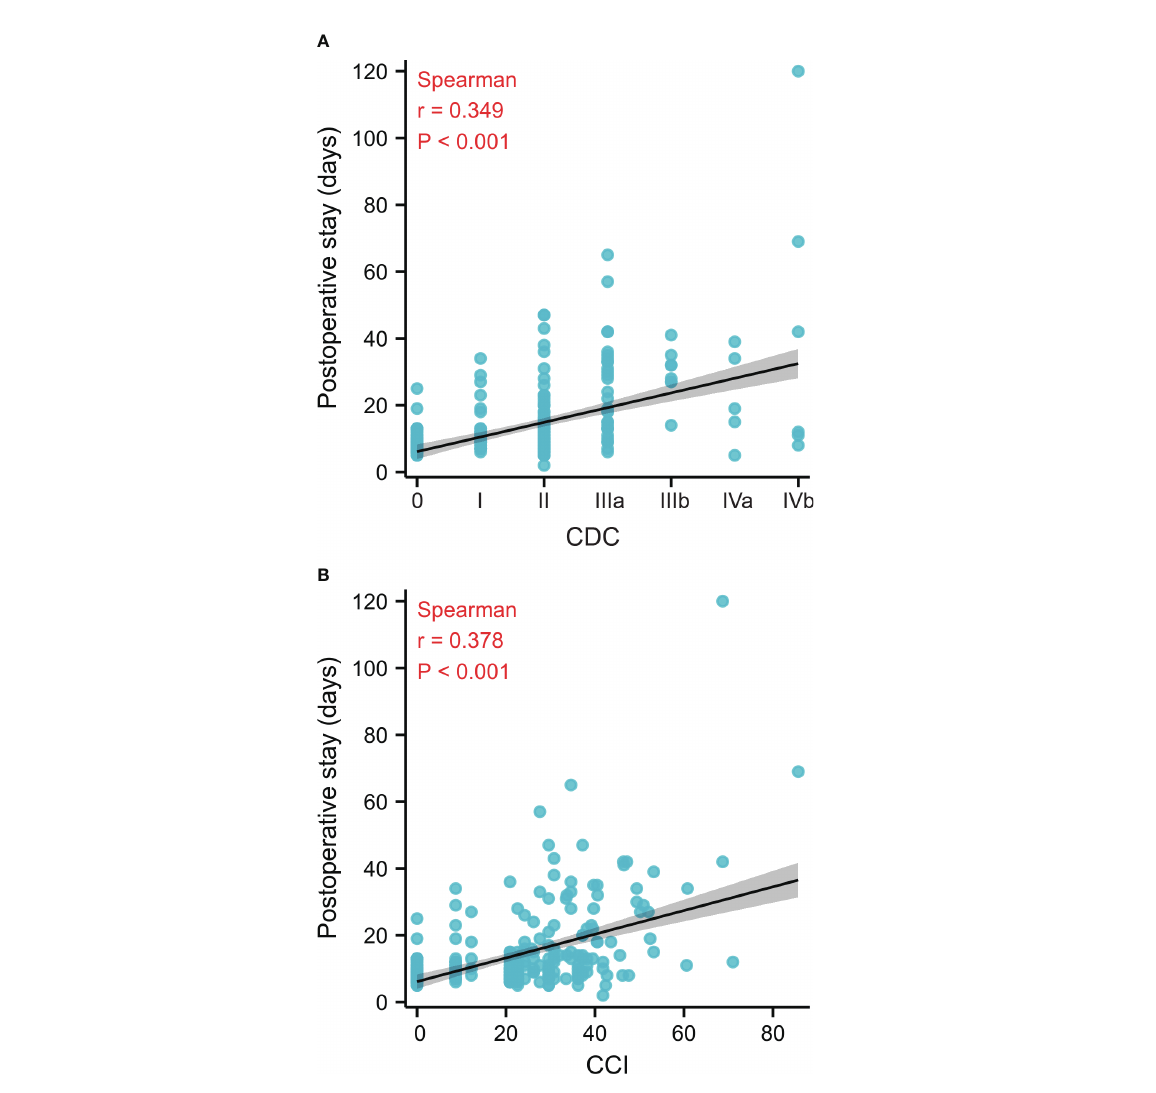
FIGURE 2 (A) : Correlation between CDC and postoperative stay (r = 0.349, p < 0.001). (B) : Correlation between CCI and postoperative stay (r = 0.378, p < 0.001). CDC, Clavien – Dindo classi fi cation, CCI, Comprehensive Complication Index. The correlations between variables were analyzed using the Spearman rank correlation coef fi